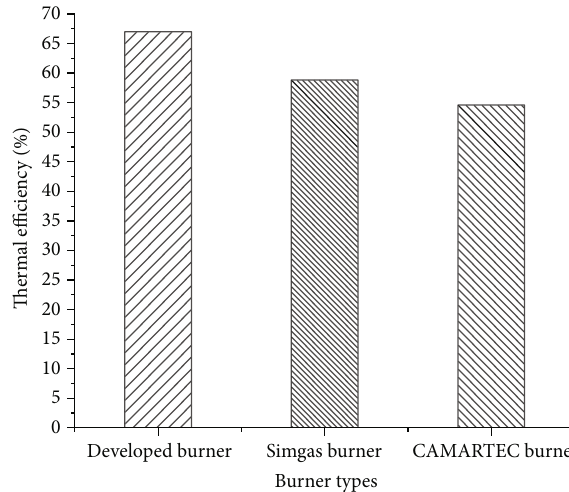
Figure 10: Thermal e ffi ciency in the simmering phase of the developed burner and the Simgas and CAMARTEC